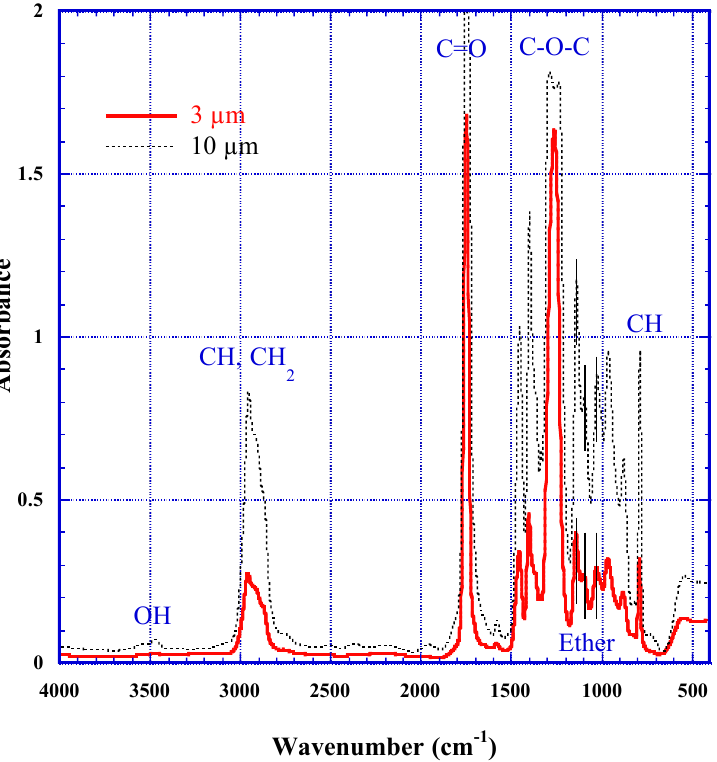
Figure 4. FT-IR spectra of PADC films with thicknesses of 3 and 10 µm.